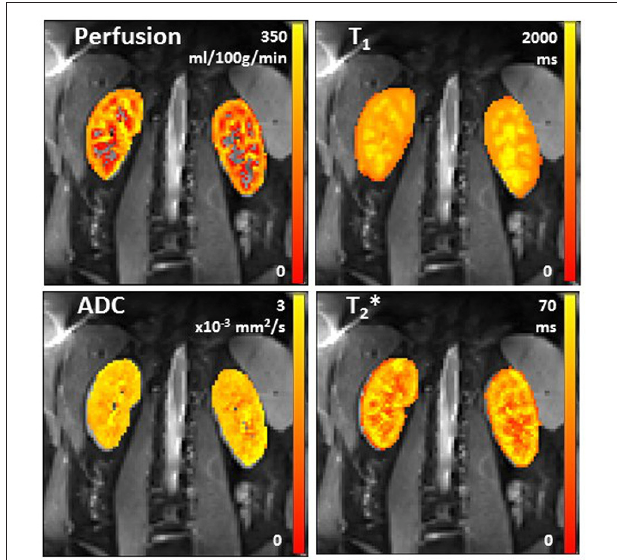
FIGURE 4 | Example arterial spin labeling perfusion, longitudinal relaxation time T 1 , ADC (apparent diffusion coefficient), and transverse relaxation time T 2 * maps in a healthy